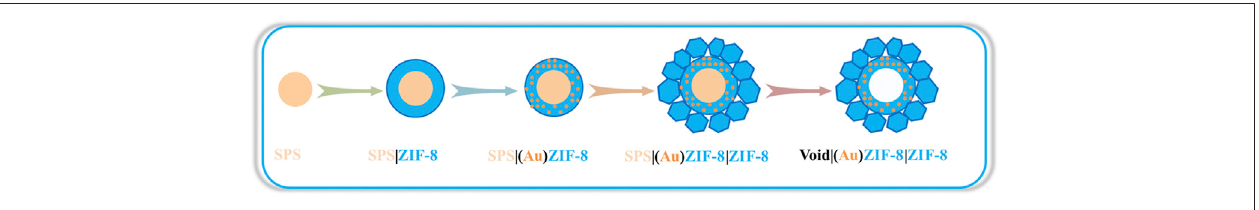
FIGURE 1 | Growth procedure for the